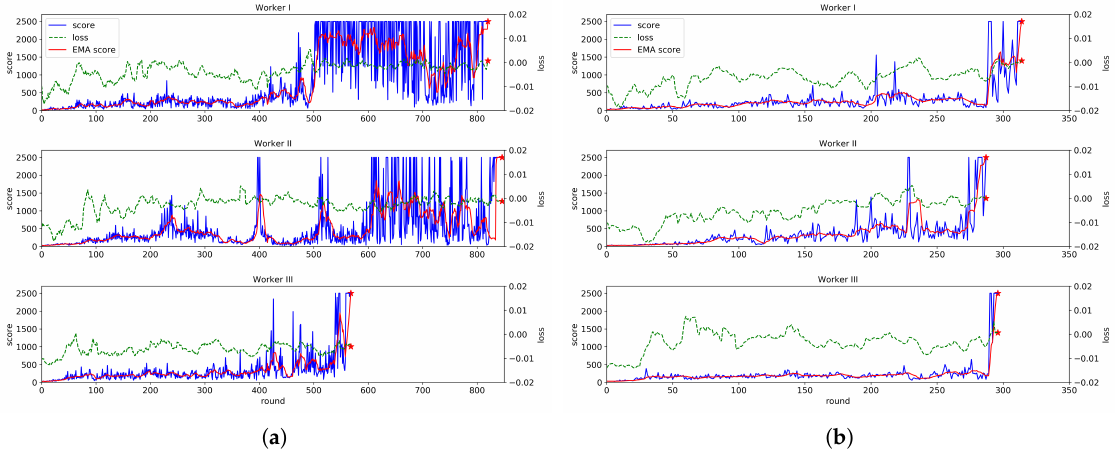
Figure 5. Effectiveness of the proposed federated reinforcement learning scheme. The blue line represents the score for each round, and the red line represents the weighted moving average (WMA) of the scores from the last 10 rounds. The green dotted line indicates the loss value for each round. ( a ) Change of score and loss values without the proposed scheme. ( b ) Change of score and loss values with the proposed